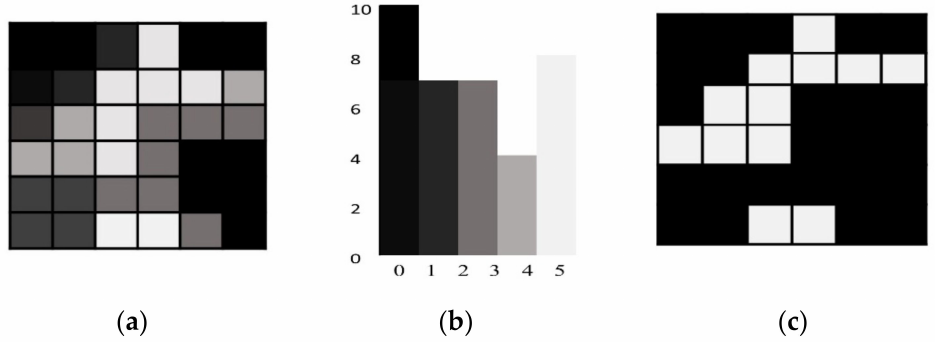
Figure 4. Otsu’s thresholding for image binarization. ( a ) Grayscale image, ( b ) image histogram, and ( c ) binarized image using an optimal threshold of T =